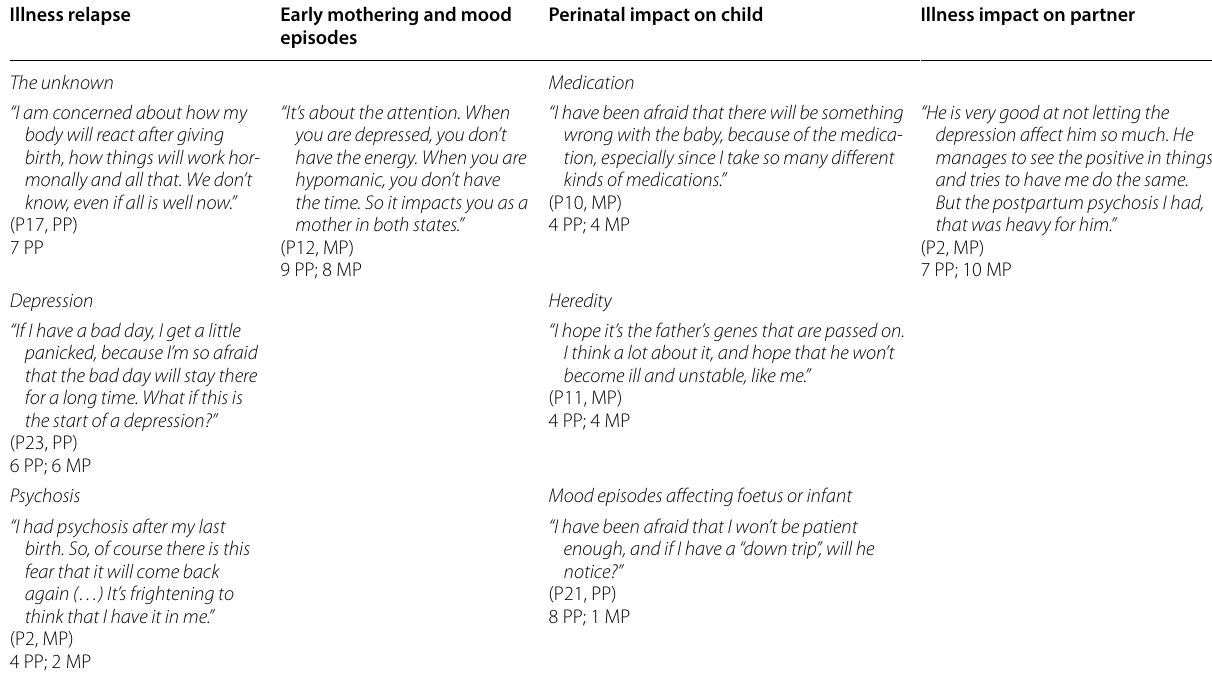
Table 3 Themes and subthemes of perinatal concerns Illness